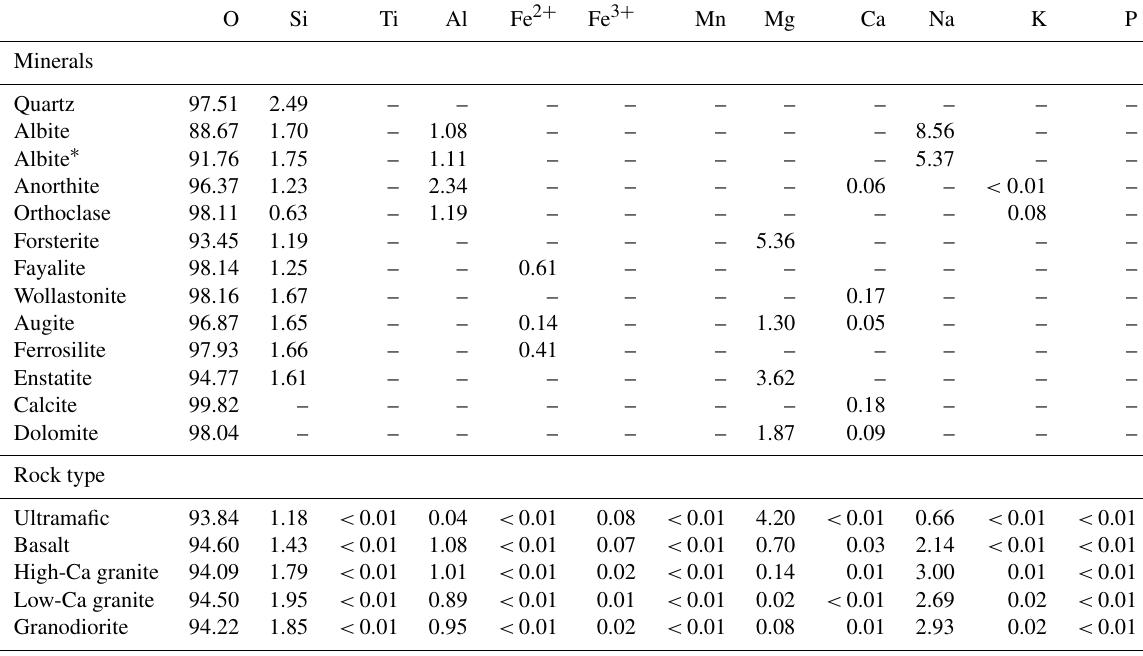
Table 3. Percentage of total theoretical predicted modern SLHL in situ 14 C production ( P CDpred ) by element for each mineral and rock type considered. O Si Ti Al Fe 2 + Fe 3 + Mn Mg Minerals Quartz Albite ∗